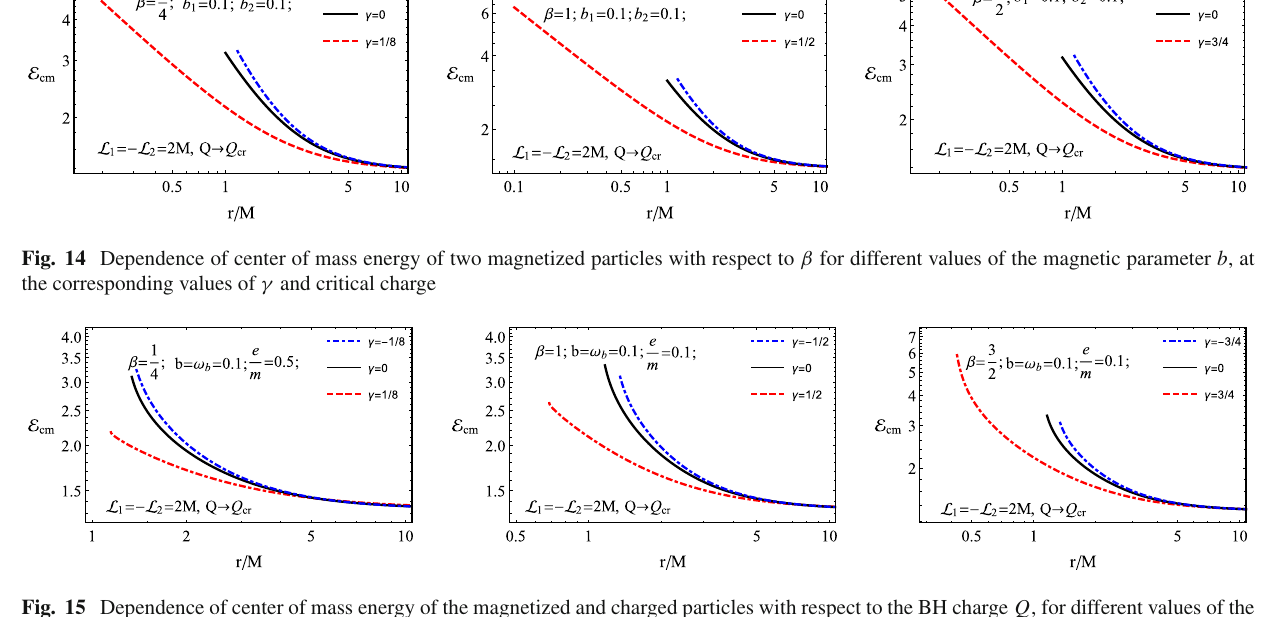
Fig. 15 Dependence of center of mass energy of the magnetized and charged particles with respect to the BH charge Q , for different values of the magnetic parameter b